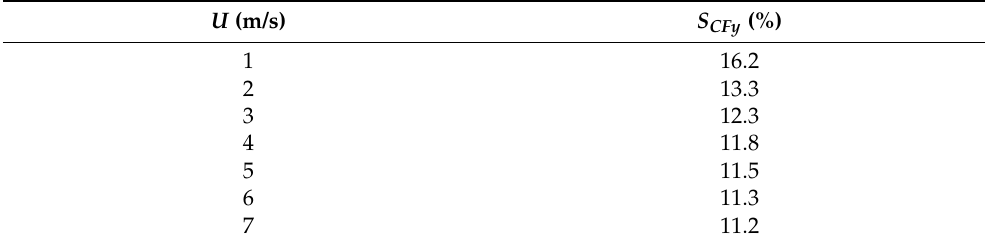
Table 2. Random uncertainty values for C Fy using the